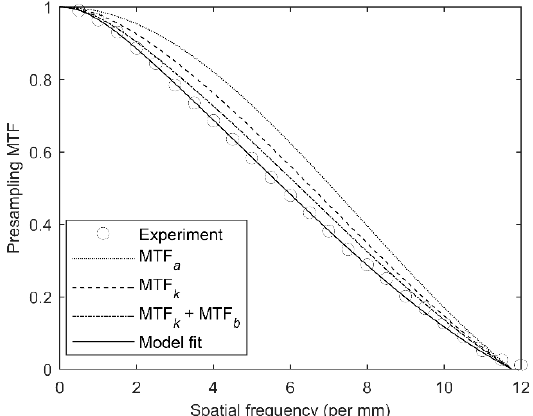
Figure 3. The MTF( f ) for a negatively biased a -Se detector of 200 µm thickness at 28 kVp (tungsten anode) X-ray exposure with 2.5 mm Al filtration. The applied electric field F = 10 V/µm and the